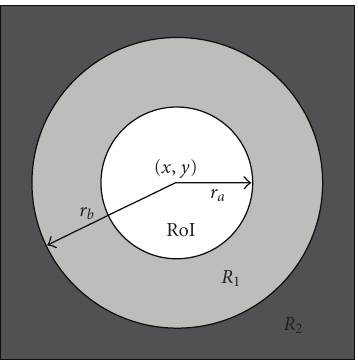
Figure 2: Areas of di ff erent priorities in an image centered at the center of